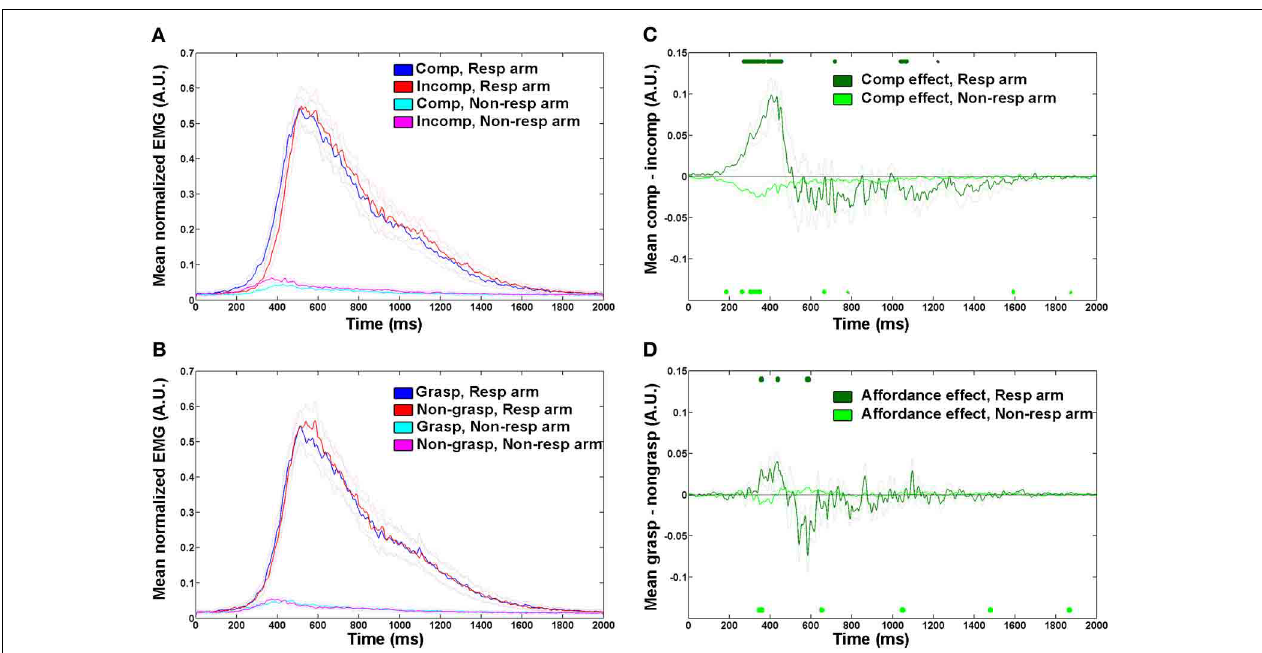
FIGURE 2 | Mean EMG traces showing spatial compatibility and affordance effects. (A,B) Mean normalized EMG trace across all trials and participants in each condition in responding and non-responding arm for (A) spatial compatibility effect; (B) affordance effect. Dotted lines denote between-participant variability (SEMs). Time zero on the x-axis represents the stimulus presentation onset. (C,D) effect sizes in the responding- and non-responding arms for (C) spatial compatibility